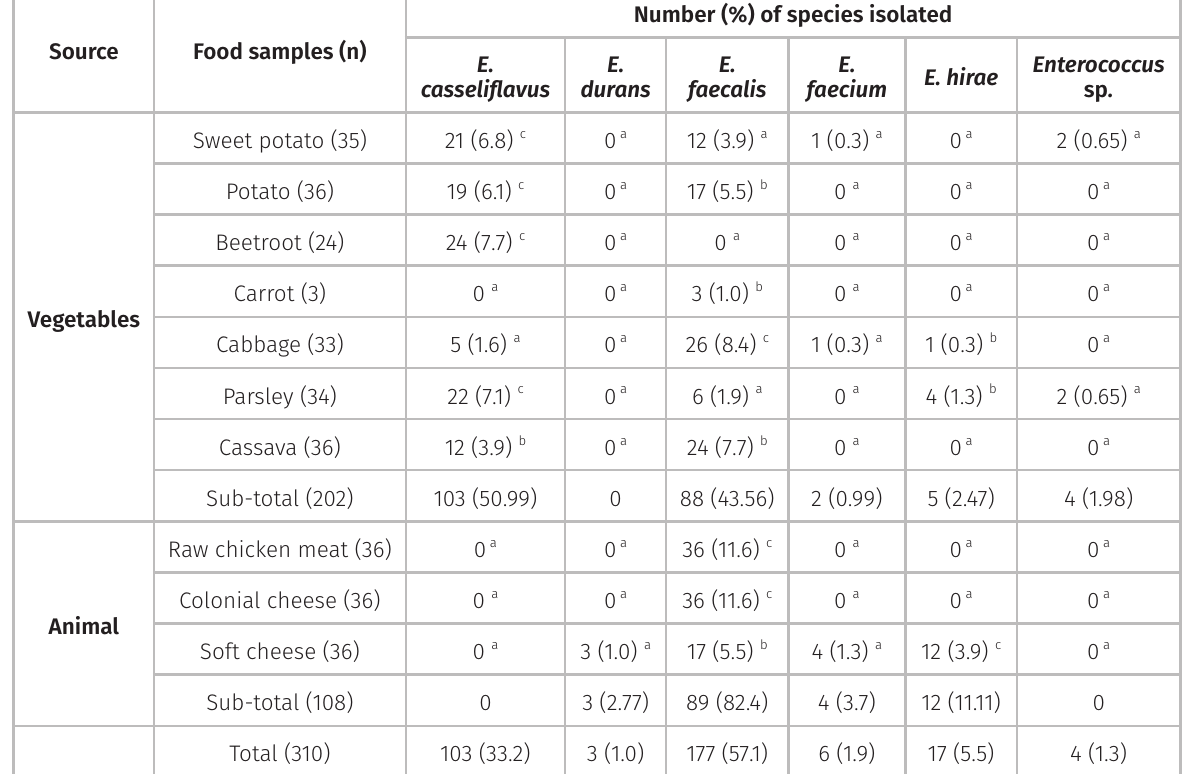
Table III. Distribution of Enterococcus species among food samples. Source Food samples (n)